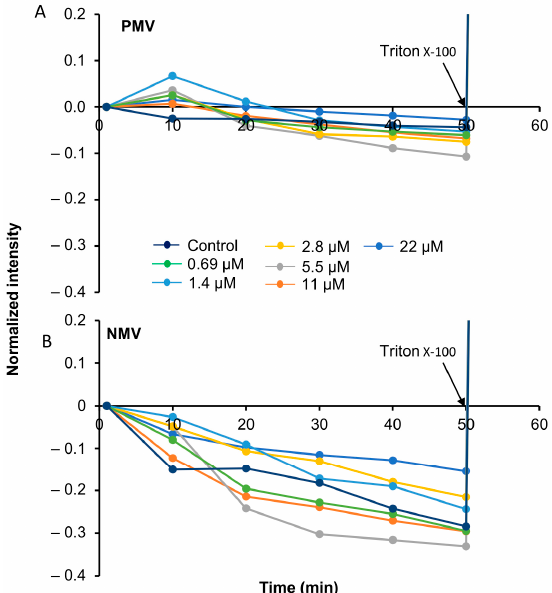
Figure 3. Interactive studies of the peptide with lipid membrane and the permeabilization effect of the peptide through carboxyfluorescein release in the LUV. ( A ) showing PMV and ( B ) showing NMV. The fluorescent intensity from vesicles was recorded for different concentrations of the peptide, incubated over an hour. A representative graph is depicted; data were acquired from a minimum of 3 experiments.